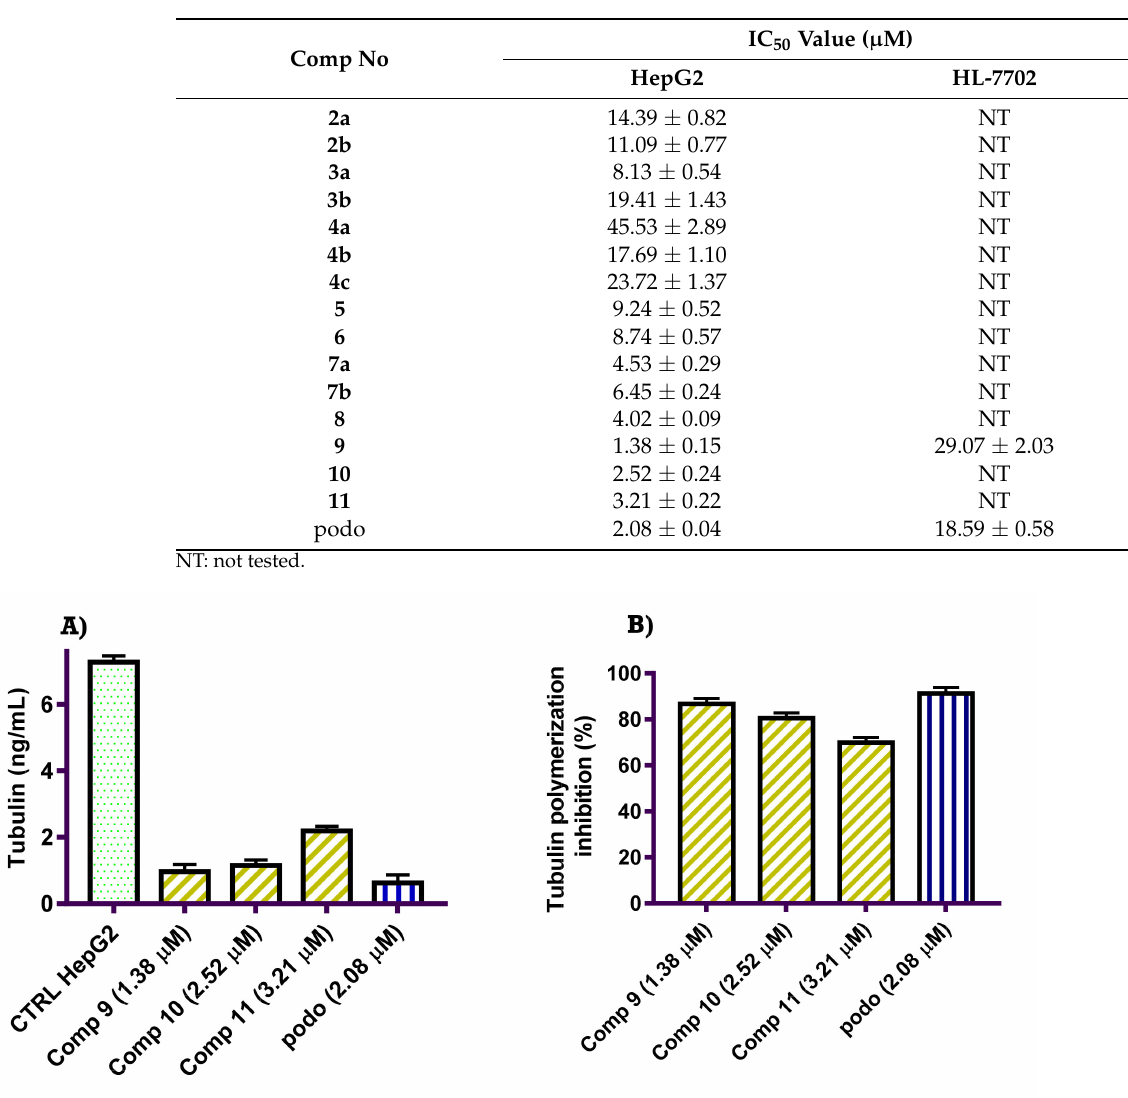
Table 1. Cytotoxic screening of the tested trimethoxyphenyl-based analogues 2a – 11 . Values are are the mean ± SE.